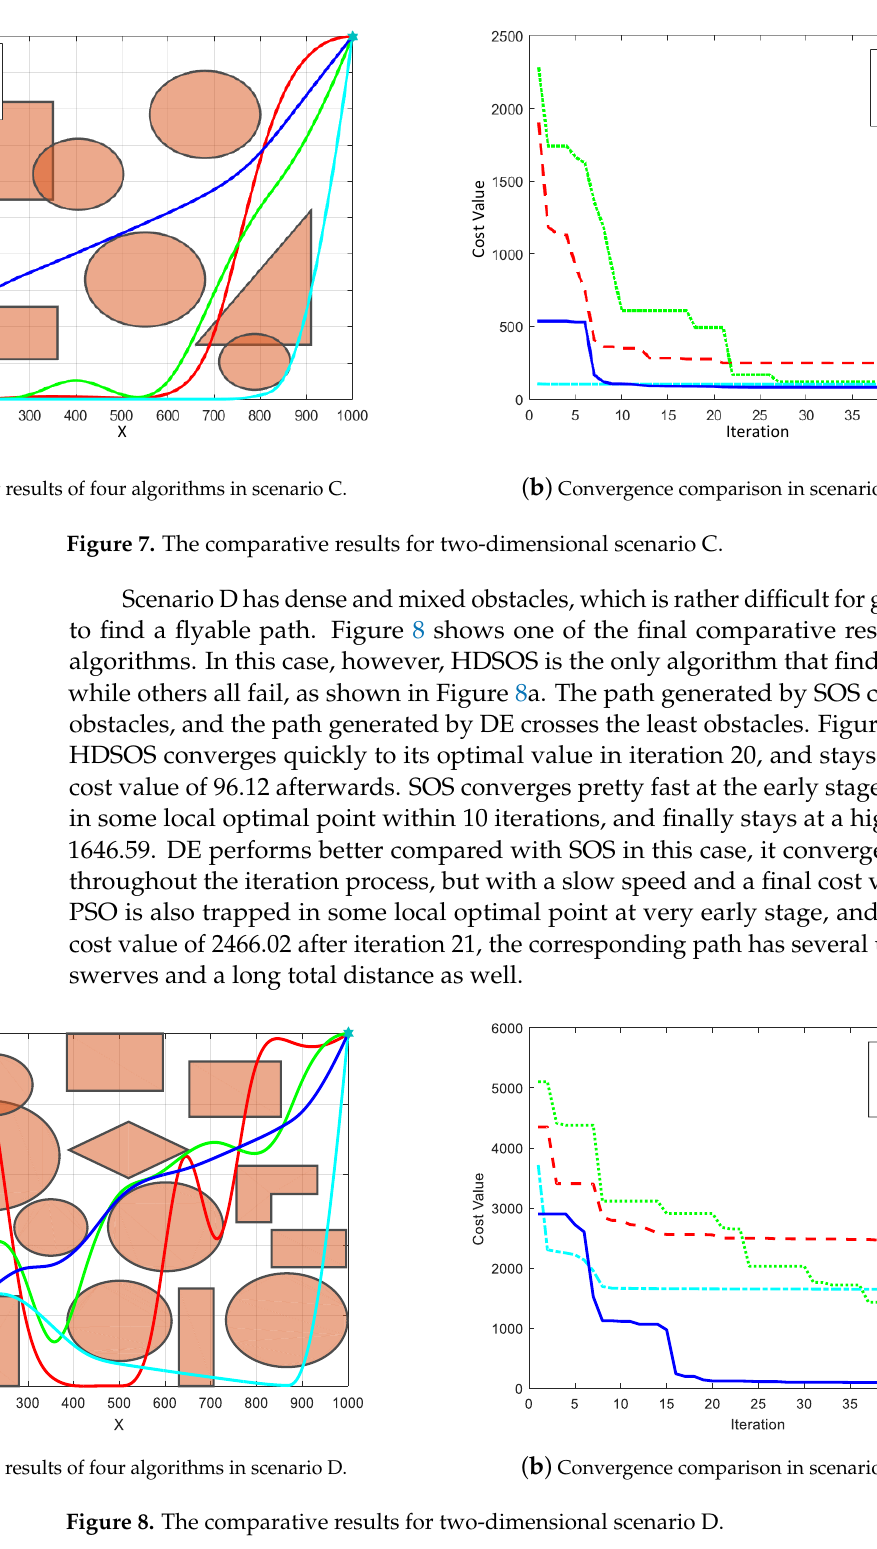
Figure 8. The comparative results for two-dimensional scenario